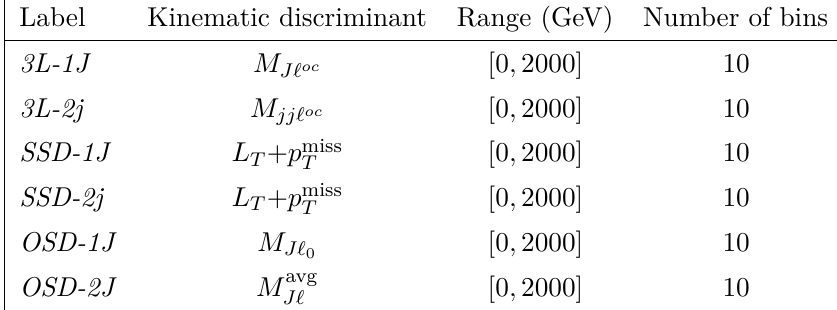
Table 9 . Binning scheme of different signal